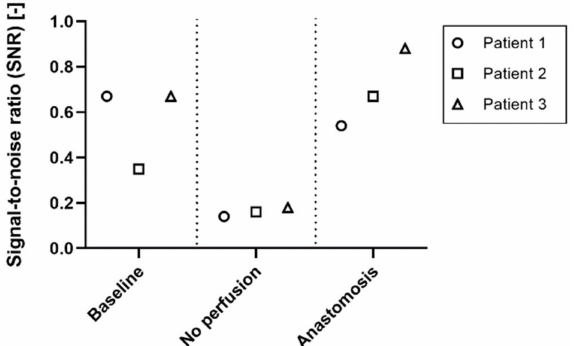
Figure 6. Signal-to-noise ratio (SNR). The SNR is low (<0.2) in the no perfusion conditions of all three patients, whereas it is much higher in the perfused conditions (>0.3; baseline and anastomosis